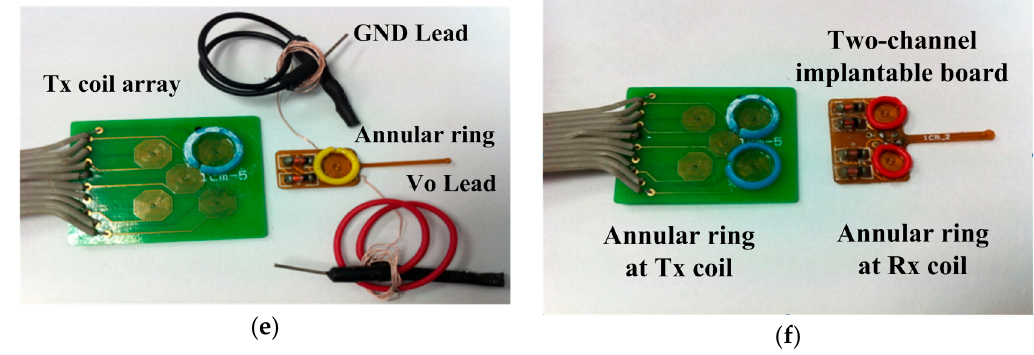
Figure 3. ( a ) The schematic diagram of the in vivo experimental set-up: the stimulating electrode and the recording electrode were located at the bilateral primary visual cortex. The implantable stimulator board acquired the voltage stimulus by inductively coupling with the external transmitter circuit. The neuronal responses were recorded by electrode and conveyed to the physiological signal acquisition system at the same time; ( b ) Photograph of the in vivo experiment: the implantable stimulator and recording electrode on the dura mater above primary visual cortex; ( c ) Cross-section schematic of electrical epidural stimulation; ( d ) The output stimulating voltage pulse signal (in blue color) at the implantable pulse generator (IPG) board. The yellow trace was input signal at external transmitter; ( e ) The transmitting coil array board with one annular ring (in blue color) and the single-channel implantable naked interface with two testing leads and an annular ring (in yellow color); ( f ) The transmitting coil array board with annular rings (in blue color) and the two-channel implantable board with annular rings (in red color) with 2 mm height. Table 2. The thickness of flexible printed board